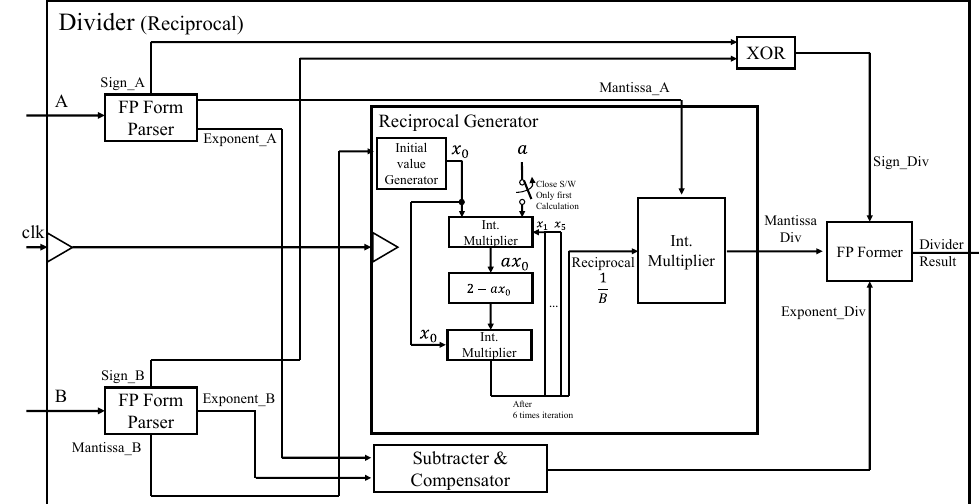
Figure 5. The architecture of floating-point divider using reciprocal.